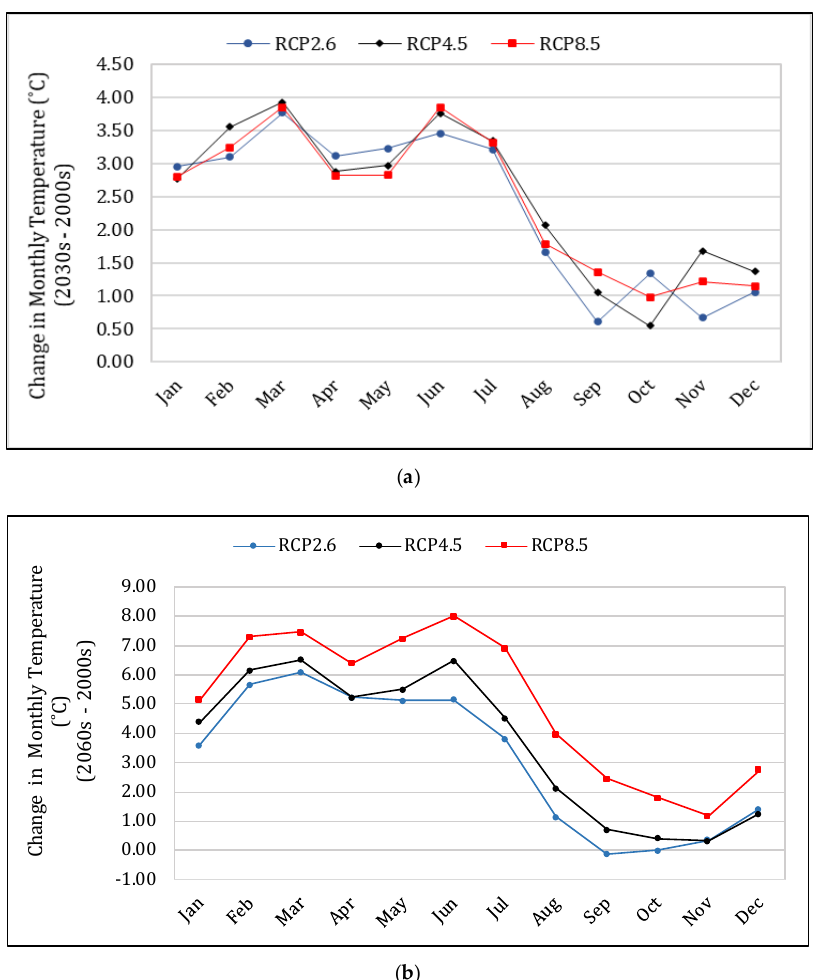
Figure 6. Projected change in monthly temperatures during 2021–2050 ( a ) and 2051–2080 ( b ) in the central zone (Charlottetown) compared to those that prevailed during 1991–2020. Table 8. Average temperatures ( ◦ C) that prevailed in the central zone (Charlottetown) during the 2000s and expected under different projections during the 2030s and 2060s.